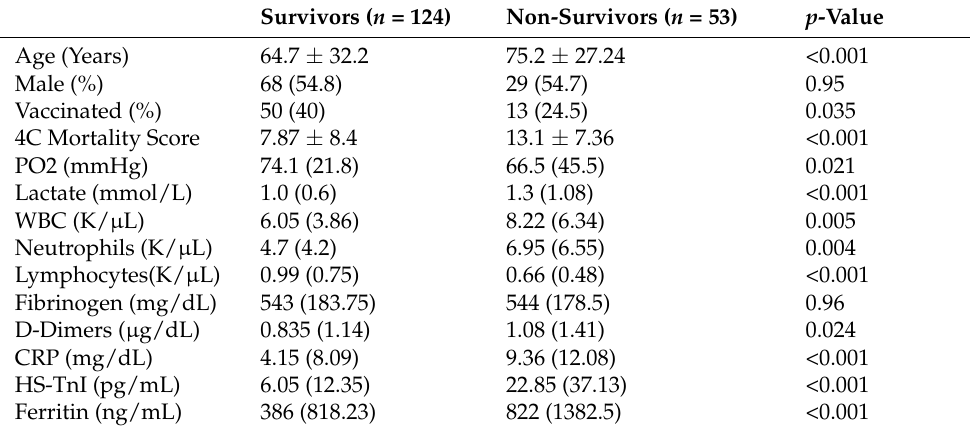
Table 1. Demographic, clinical and laboratory characteristics of the